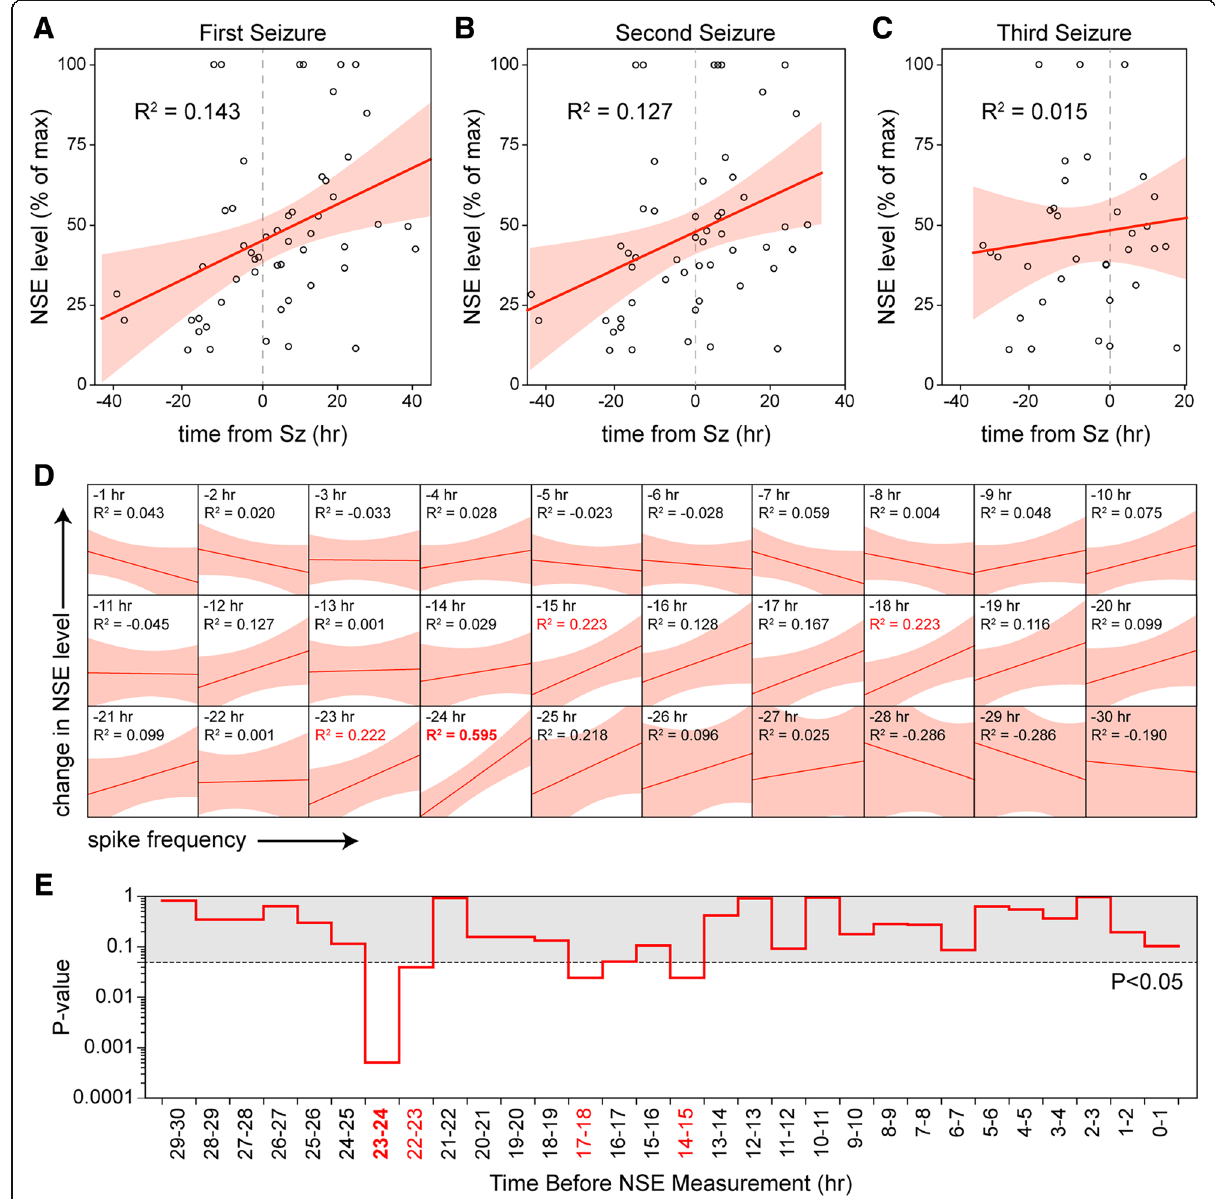
Fig. 5 NSE levels increase after seizures and after increased spiking on the EEG. a NSE measurements, were converted to percent of maximum for each individual. The time of the first clinical seizure was set to t = 0 and the normalized NSE measurements were plotted against number of hours before or after the seizure (each circle represents one NSE measurement). The distribution was analyzed by least squares linear regression to fit a line (red). The 95% CI for the regression is shown in solid light red. The fit (R 2 = 0.143) indicates that NSE values were higher after the first seizure than before. b The same process was applied to values relative to the second seizure time. As with the first seizure, NSE levels were higher after the second seizure than before (R 2 = 0.127). c The same process was applied to the the third seizure time. By the third seizure there was no longer a relationship between time after seizure and elevated NSE levels (R 2 = 0.015). d Continuous spike frequency data were available from EMU patients E003-E007. These data and the NSE measurements were recast as unitless values indicating increased serum concentrations or increased spike frequencies. Using standard least squares linear regression the NSE values were modeled relative to time of spike frequency measurement. Each panel shows the fitted line (red) and 95% CI for the regression (solid light red) from 0 to 1 h ( “ -1 hr) before the serum measurement through to 29-30 hr ( “ -30 h) before the serum measurement. e The P -value derived from the χ 2 analysis of a binomial maximum likelihood estimator is plotted against time relative to NSE measurement to reveal the most significant temporal epochs. The gray region shows P -values greater than 0.05; the dashed marks P =